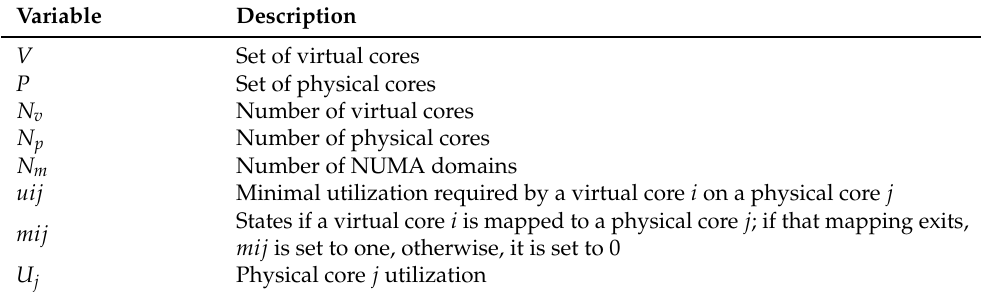
Table 1. Problem model